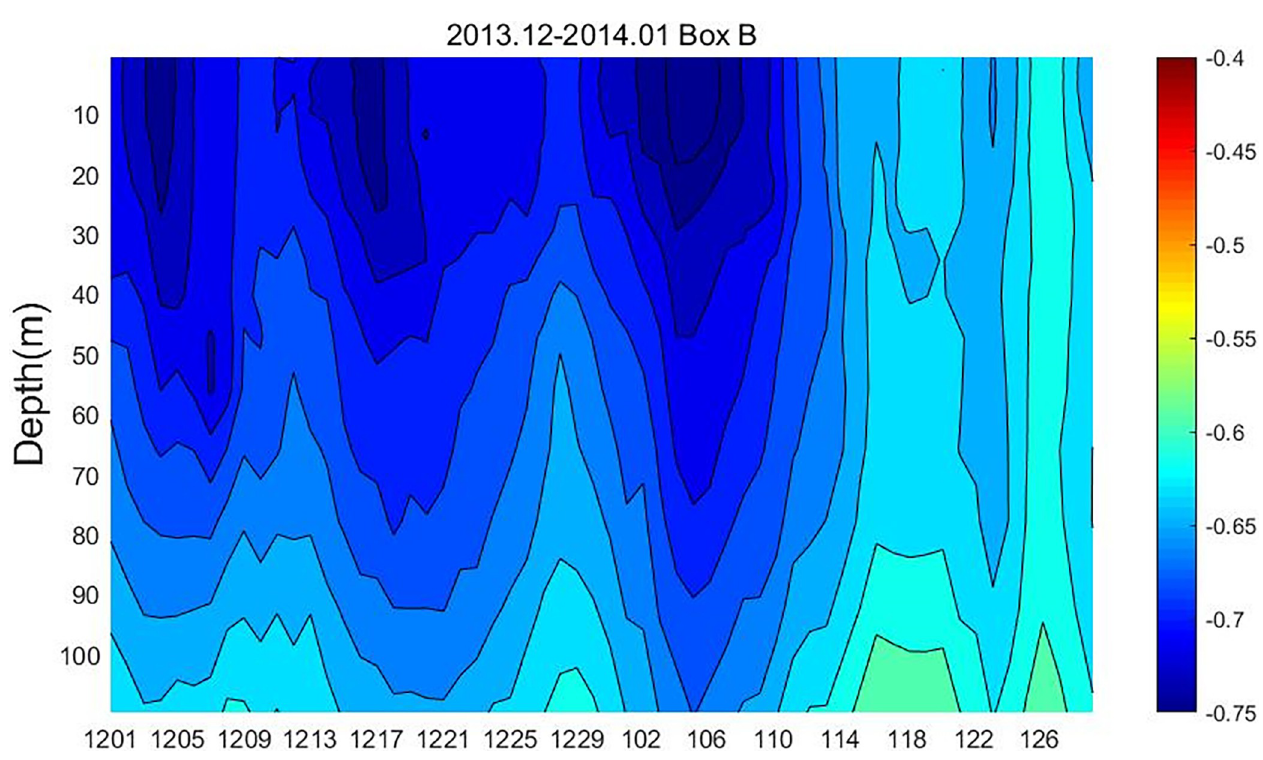
Fig 13. Time series of spatially averaged vorticity in Box B from December 2013 to January 2014.